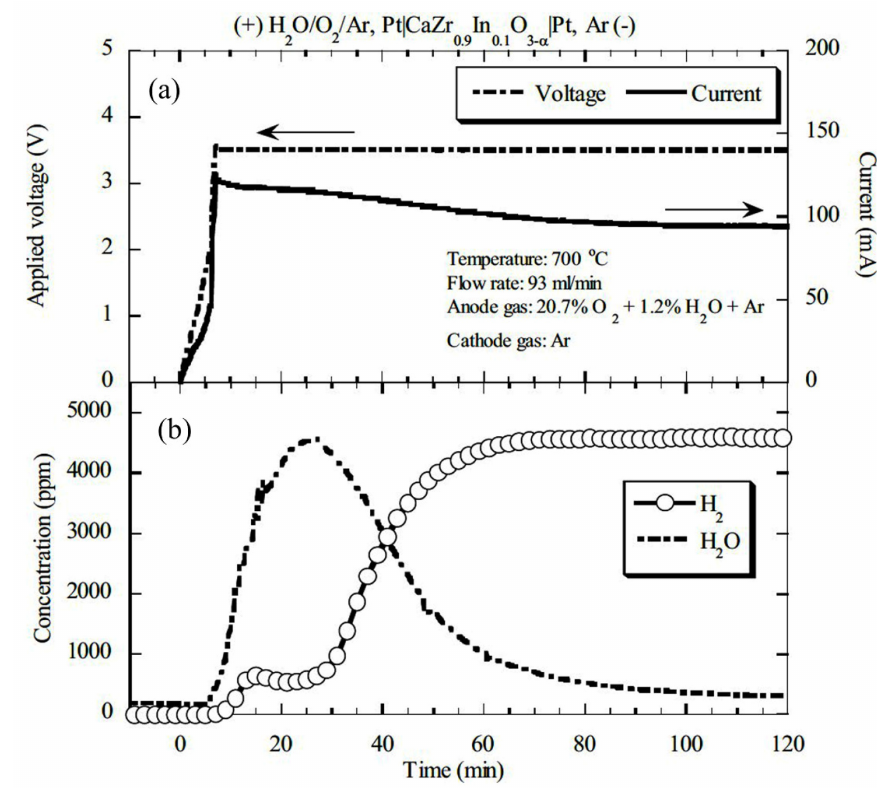
Figure 13. Time evolution of hydrogen and water vapor at the cathode outlet under the wet atmo- sphere containing oxygen; ( a ) applied voltage and current, ( b ) concentration of water vapor and hydrogen. Reprinted with permission from Ref. [97]. Copyright 2005 Taylor &